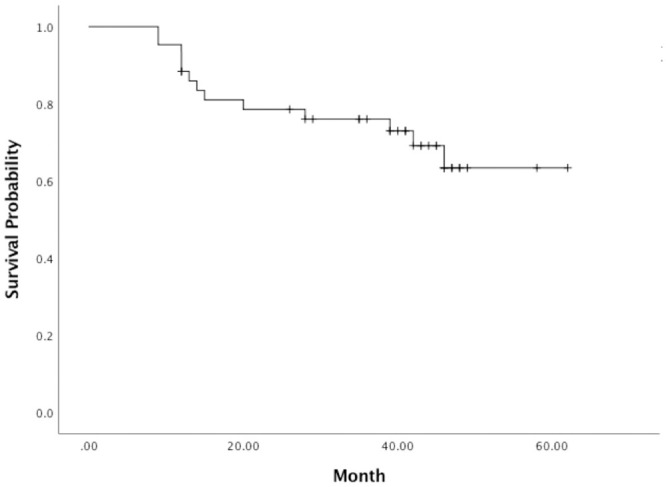
Kaplan-Meier curve of overall survival curve.